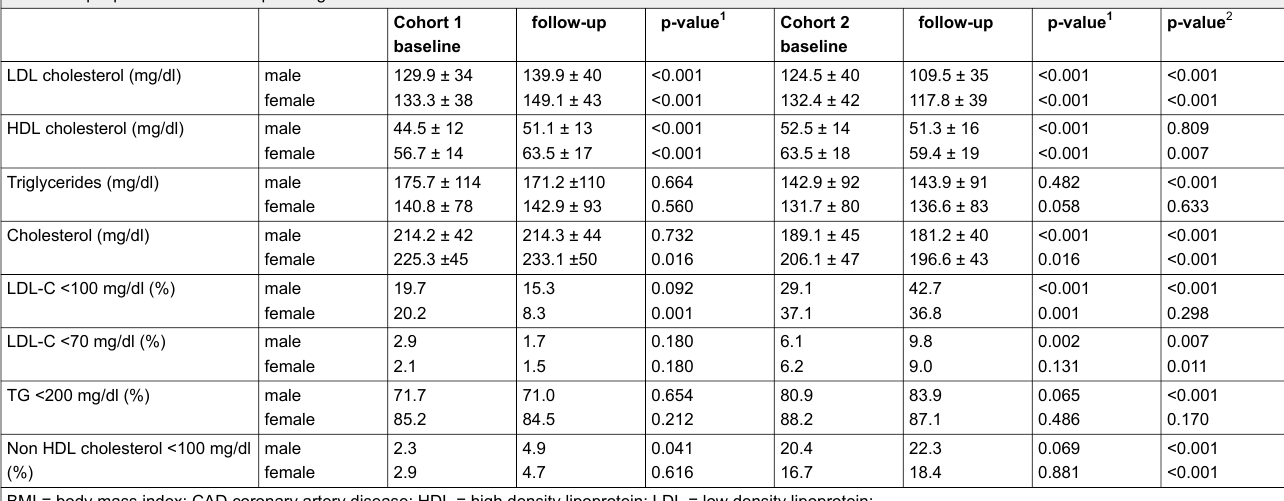
Table 3 : Lipid parameters with respect to gender.